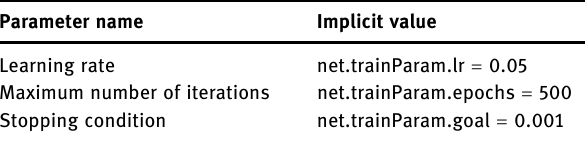
Table 4: Setting of train ()